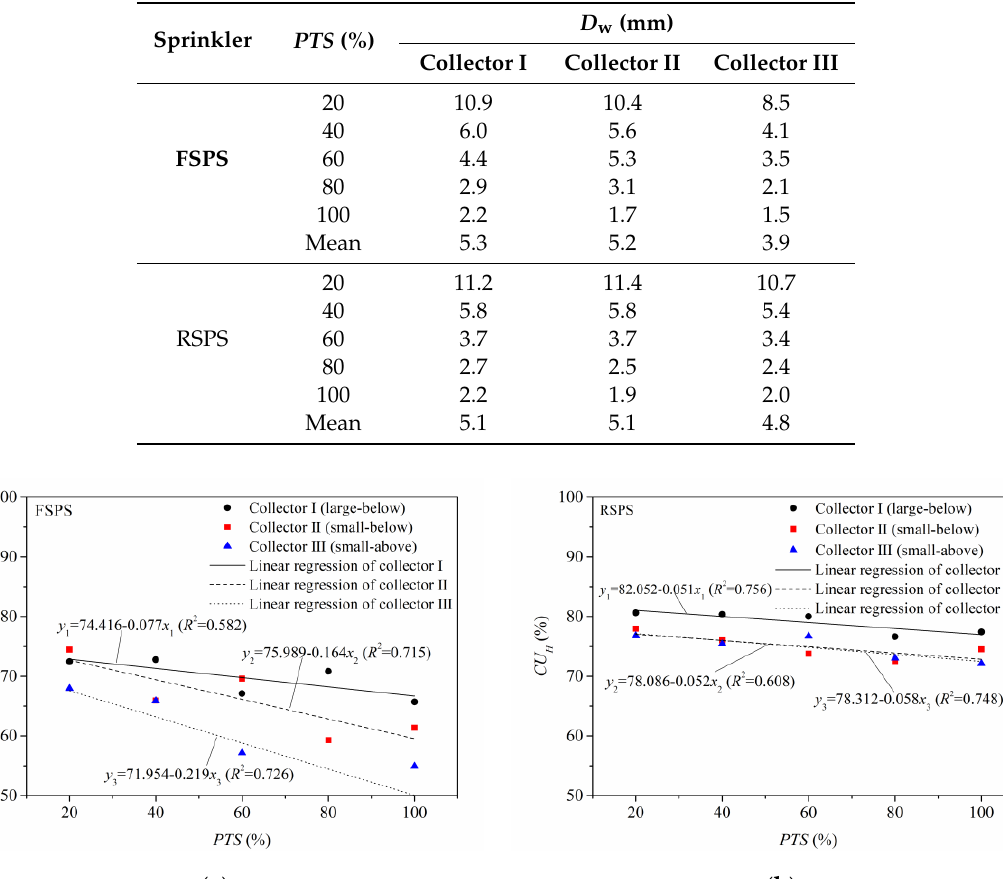
Table 4. Weighted average water application depths for the three types of collectors at the five travel speeds. Sprinkler PTS (%)